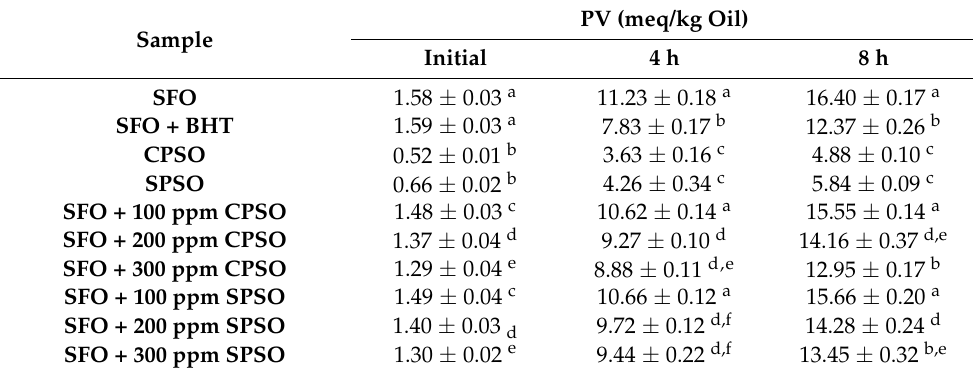
Table 4. Peroxide value of oil samples in response to heat